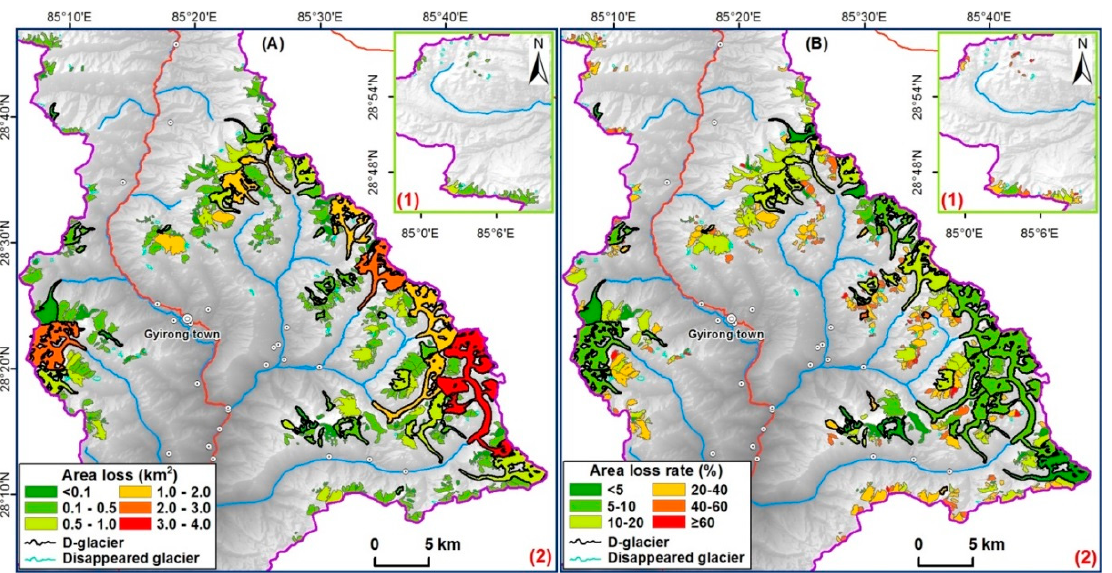
Figure 3. Glacier area loss ( A ) and change rate ( B ) between 1988 and 2015. The glacier extents shown in both panels were mapped from 1988 imagery.